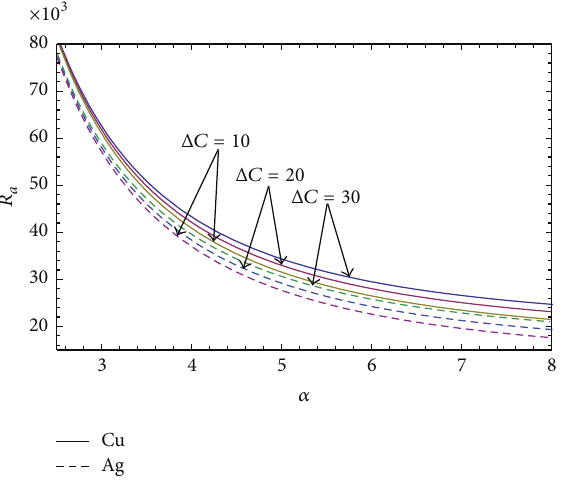
Figure 7: Effect of Δ𝜙 on metallic